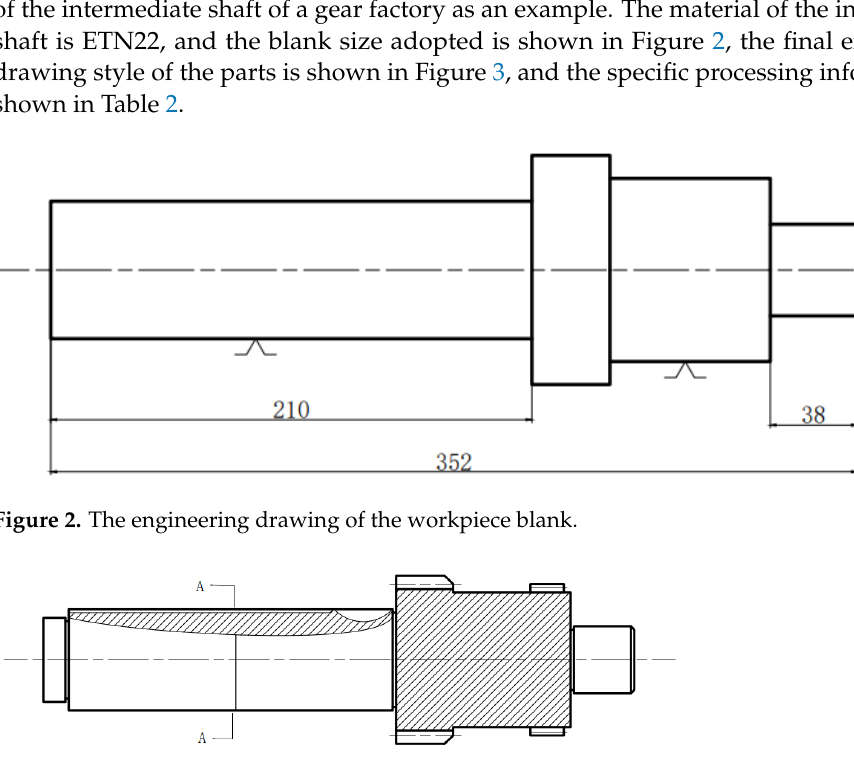
Figure 3. The engineering drawing of the workpiece. Table 2. Processing information. No.